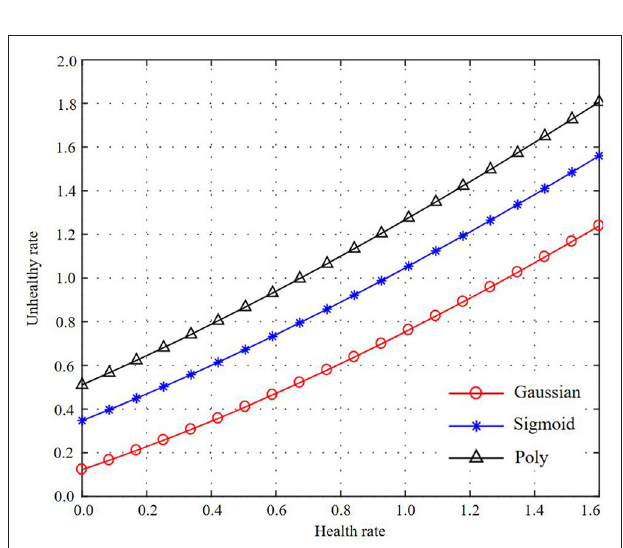
FIGURE 6 | Curve representations of three kernel functions of machine learning basic data and health information statistics.